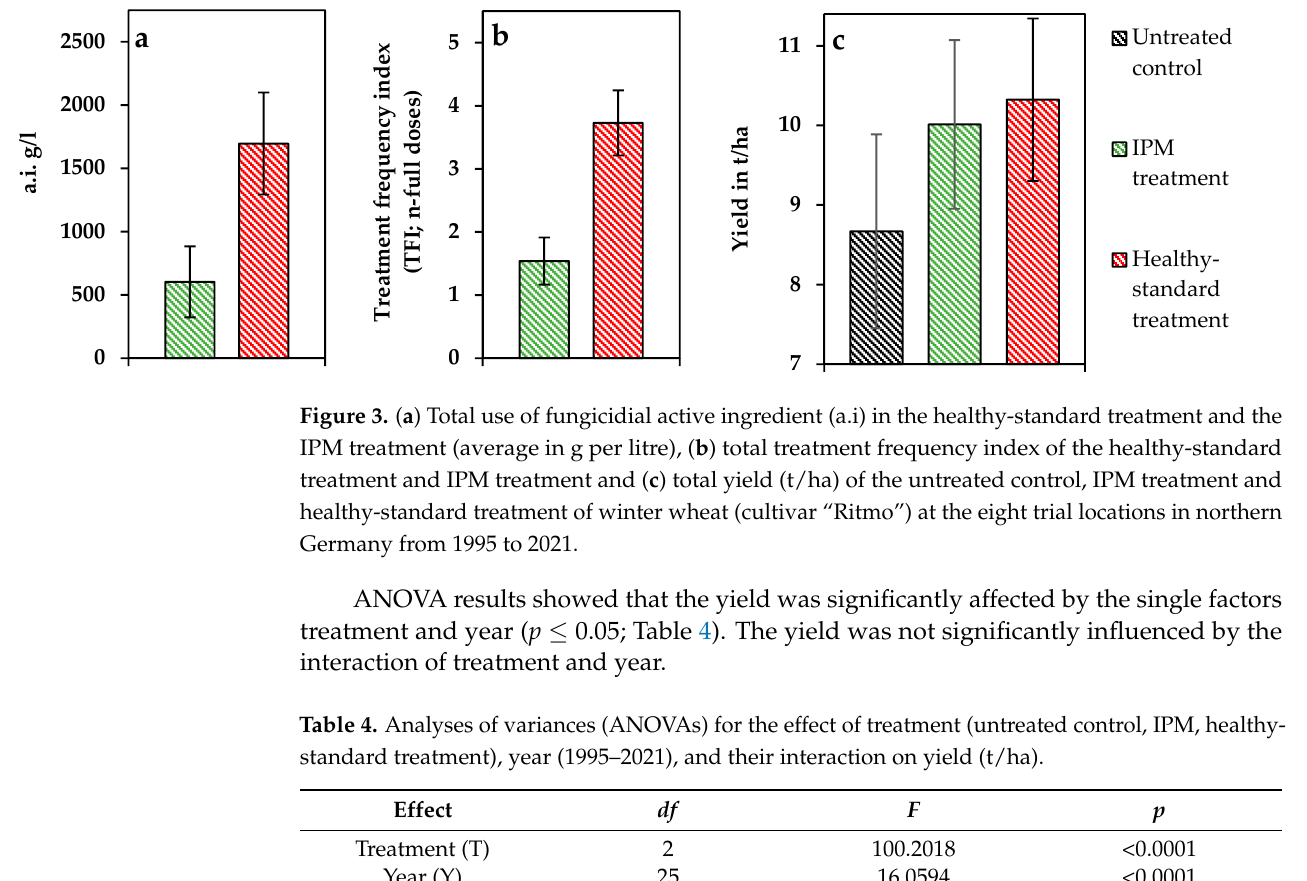
Table 4. Analyses of variances (ANOVAs) for the effect of treatment (untreated control, IPM, healthy-standard treatment), year (1995–2021), and their interaction on yield (t/ha).